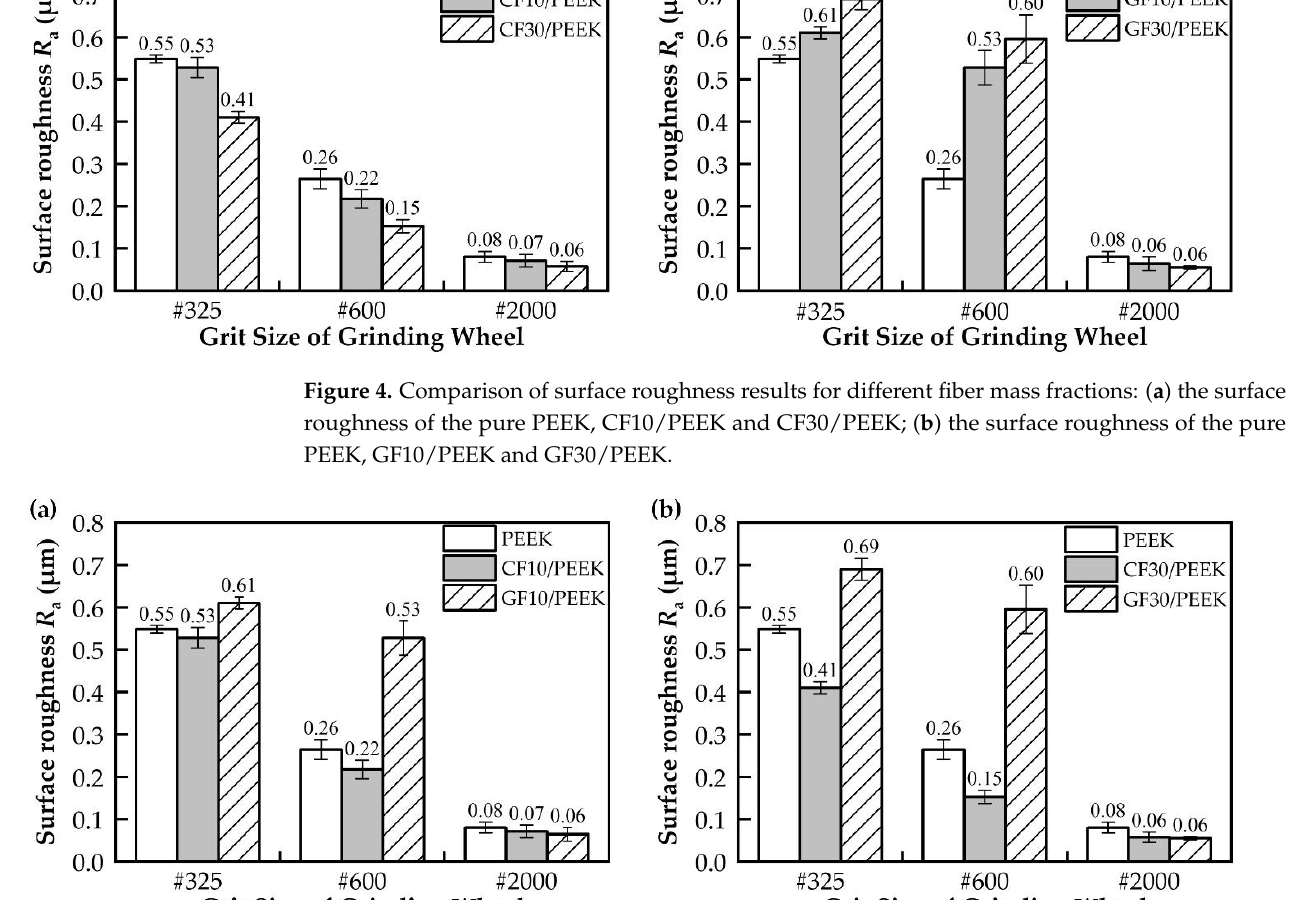
Figure 5. Comparison of surface roughness results for different fiber types: ( a ) the surface roughness of the pure PEEK, CF10/PEEK and GF10/PEEK; ( b ) the surface roughness of the pure PEEK, CF30/PEEK and GF30/PEEK.